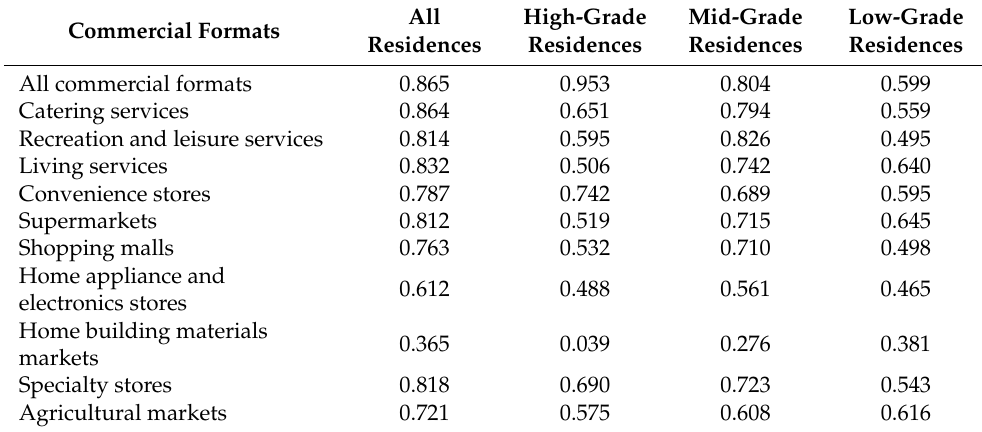
Table 4. Spatial correlation analysis of commercial and residential spaces in